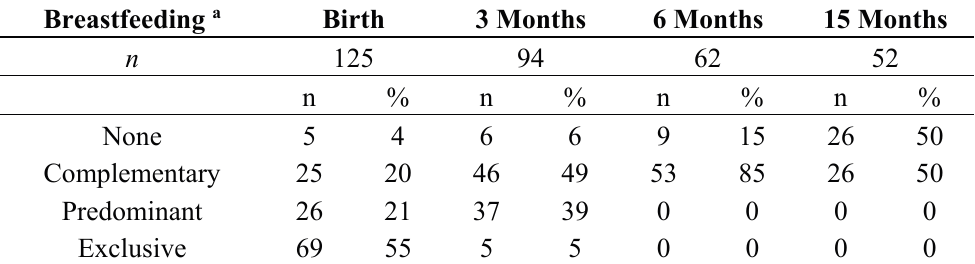
Table 2. Prevalence of